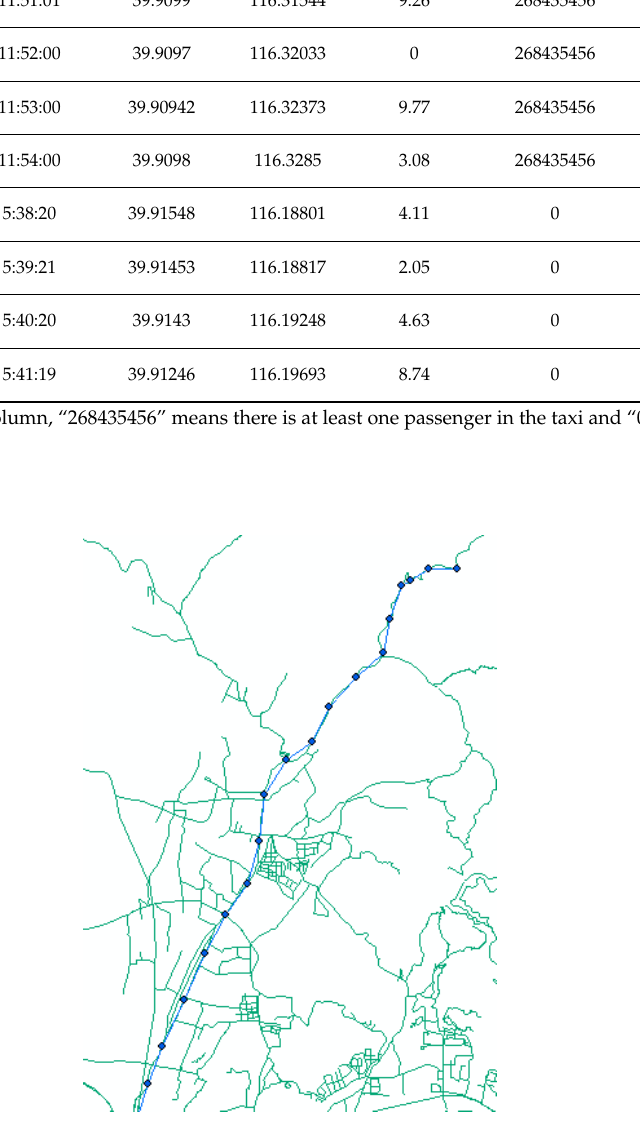
Figure 2. An example of taxi trajectories in Beijing.